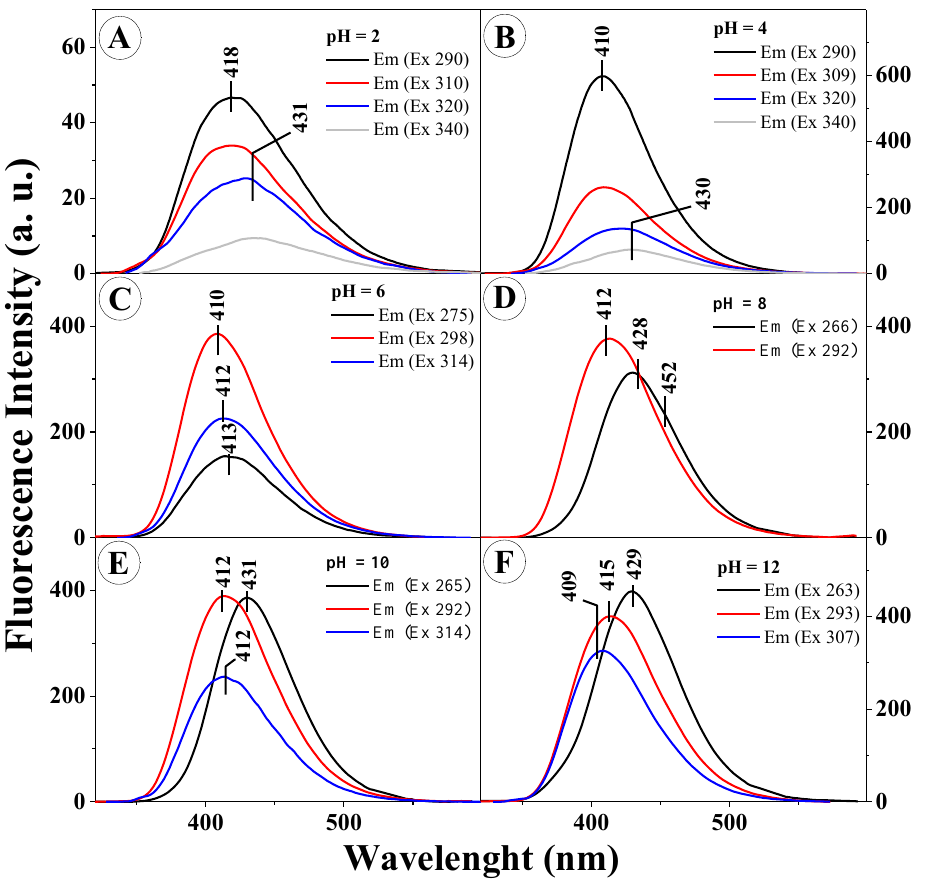
Figure 4. Fluorescence emission spectra of TS dissolved in H 2 O at di ff erent pH: ( A ) pH = 2, ( B ) pH = 4, ( C ) pH = 6, ( D ) pH = 8, ( E ) pH = 10, and ( F ) pH = 12. The excitation was set at the absorbance maximum of each sample, respectively, as pointed out in the figure. The spectra were measured at room temperature.